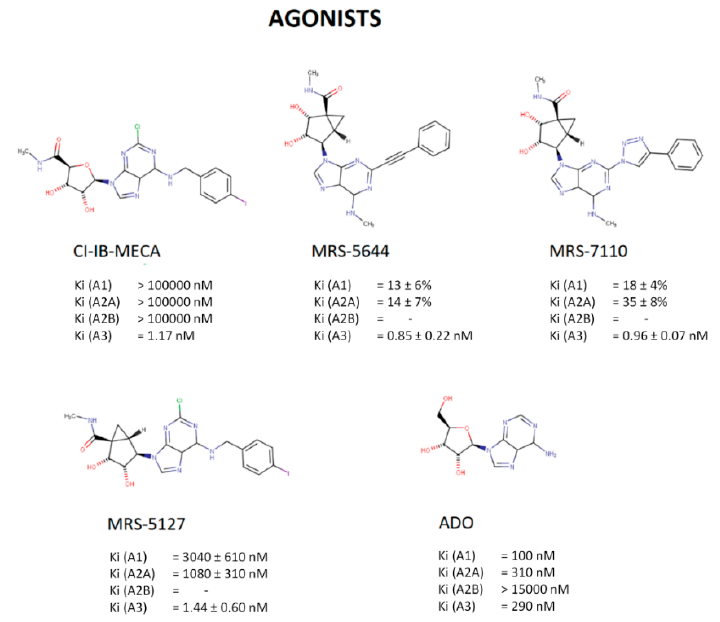
Figure 2. Chemical structures of agonists selected for docking studies. Experimental Ki values (in nM or activity assay percentages) for each receptor subtype are also reported for comparison.